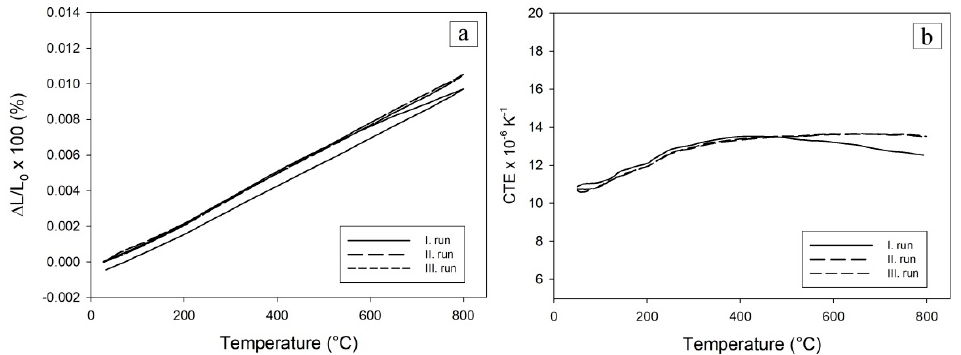
Figure 13. Relative elongation ( a ) and coefficient of the thermal expansion ( b ) were observed for the green body compact oxidized to 800 °C and subsequently thermocycled to 800 °C in the Ar atmosphere.